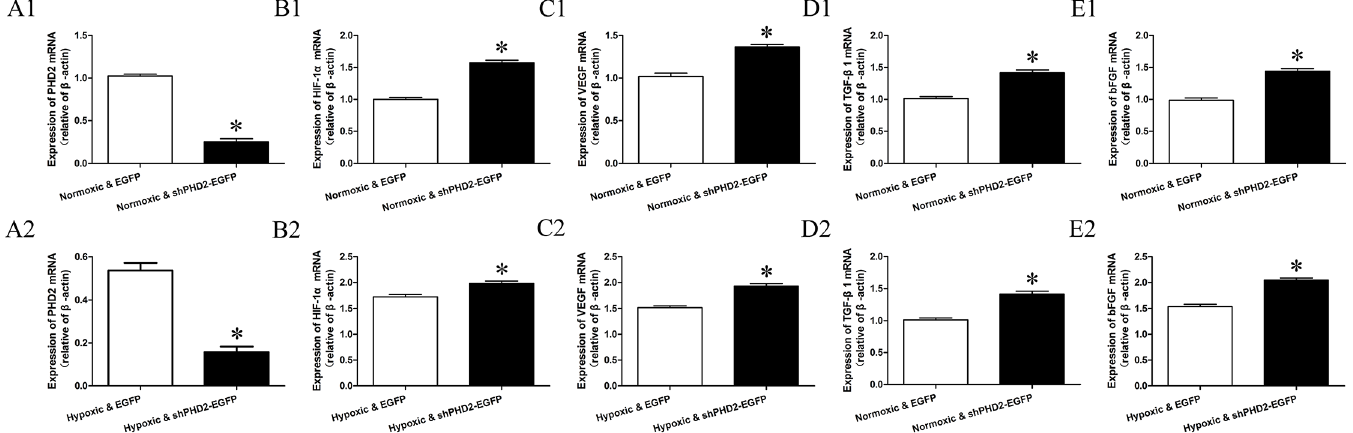
Fig 5. Effects of shPHD2 delivery on PHD2, HIF-1a, VEGF, bFGF and TGF- β 1 mRNA and protein expression in H9C2 cells. A-E: Expression of PHD2, HIF-1,VEGF, TGF- β 1and bFGF was determined by quantitative polymerase chain reaction(qPCR) in H9C2 cells of Normoxic & EGFP, Normoxic & shPHD2-EGFP, Hypoxic & EGFP and Hypoxic & shPHD2-EGFP group presented in the bar graph (asterisk indicates P -value <